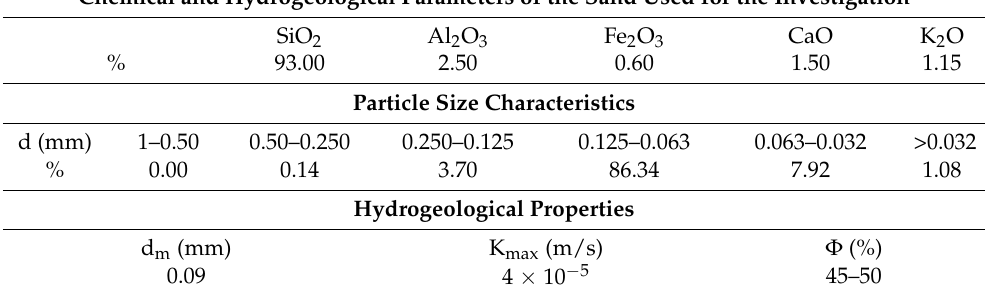
at the Hydrogeosite